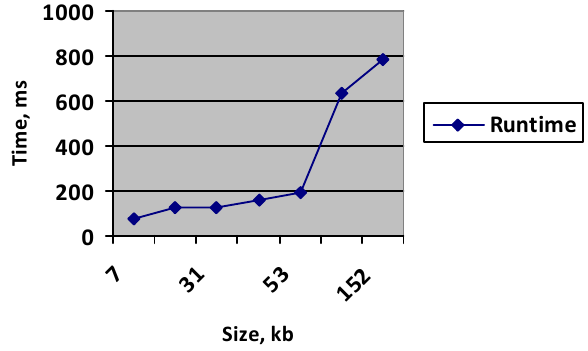
Fig. 5. Performance of the transformation